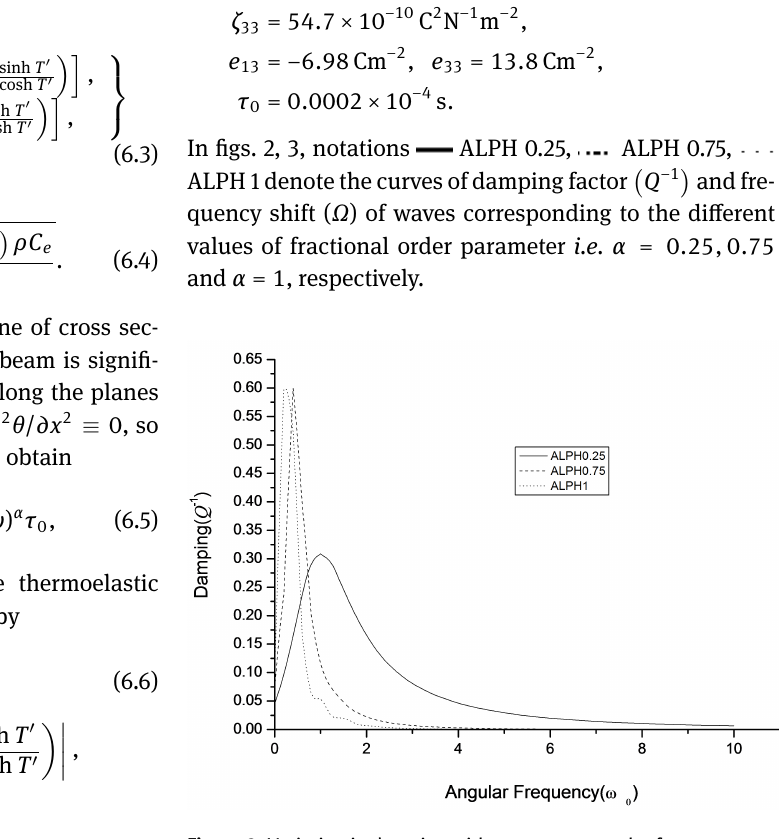
From Fig. 2, it is clear that the higher value of frac- tional order derivative causes high damping for the initial values of angular frequency. In addition to it, the curves are ultimately showing a decreasing trend and converge to minima. For ω 0 ≥ 0.5, the Q −1 is varying continuously in a